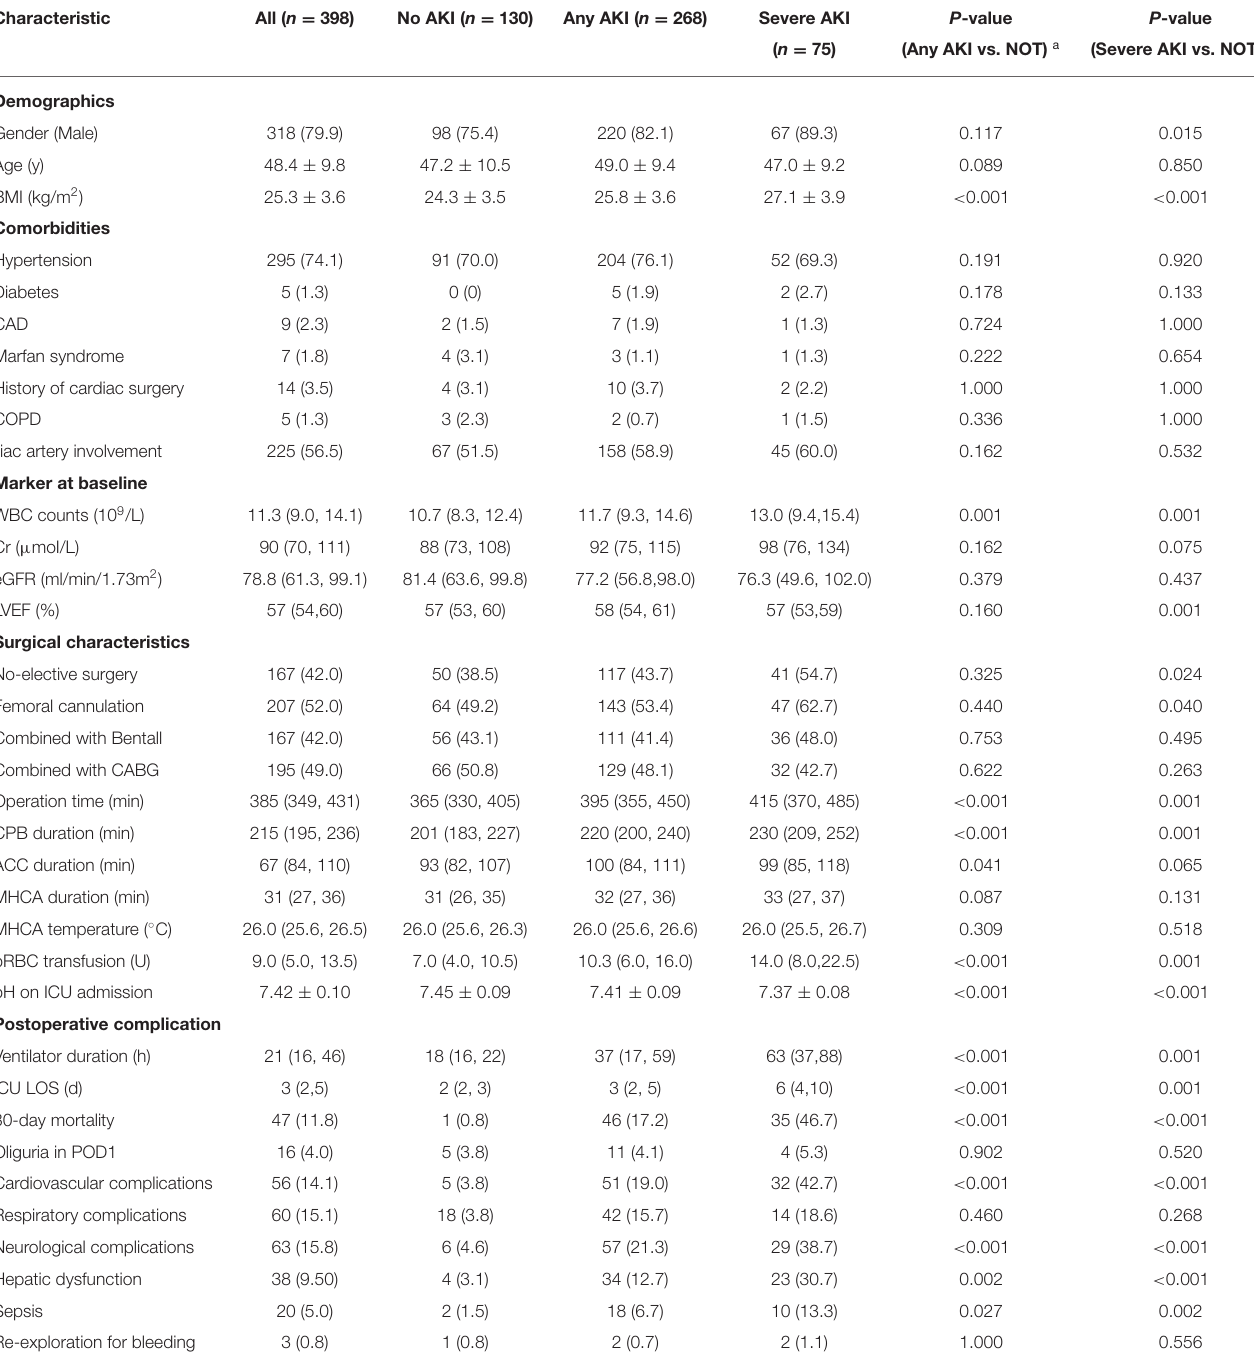
TABLE 1 | Patient characteristics by different AKI